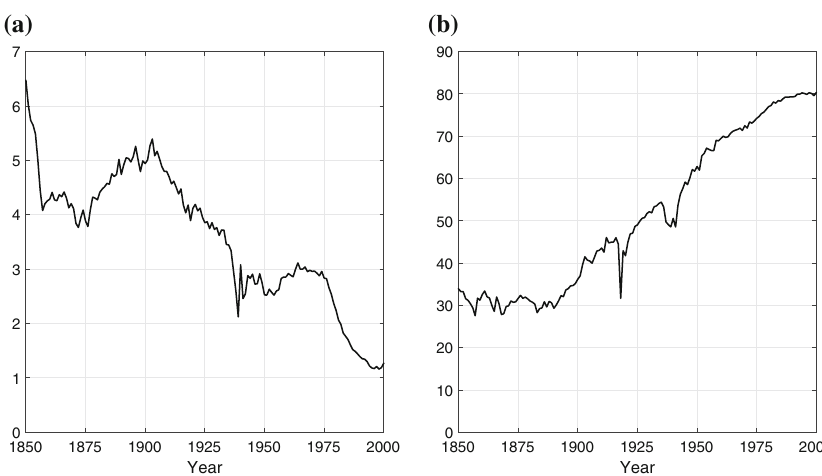
Fig. 1 Spanish total fertility rate (TFR) and life expectancy at birth: Period 1850–2000. a Total fertility rate (TFR), b life expectancy at birth. Source Authors’ estimates. Notes The TFR is the average number